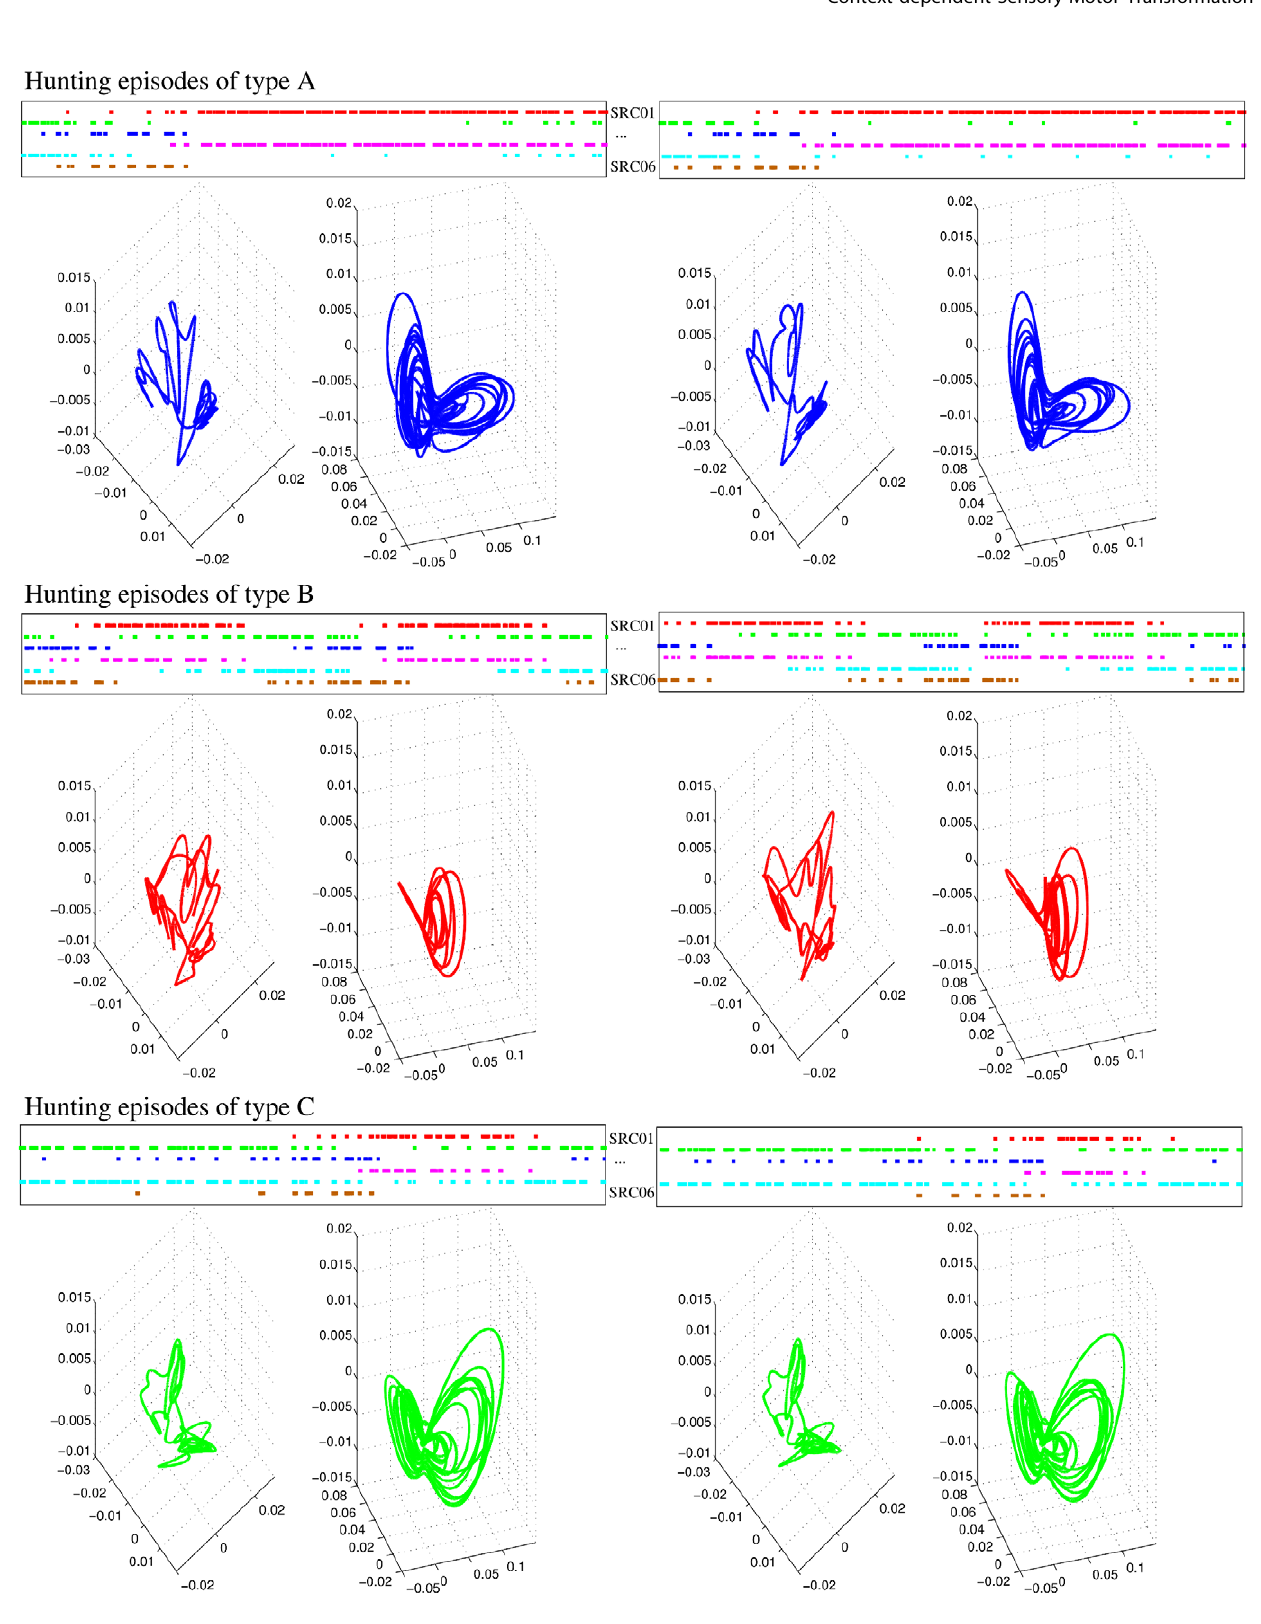
Figure 7. Principal component analysis of the sensory-motor transformation. We have selected three different types (A–C) of hunting episodes according to the duration of specific patterns of sequential activations among the SRCs. A total of six hunting episodes are shown in this figure, two examples for each kind. The top panels display the time intervals in which each neuron exceeds a threshold of 0 mV . Different colors are used to indicate each neuron. The episodes labeled as type A correspond to long activations of neurons 1 and 4 (red and magenta, respectively). The episodes labeled as type B correspond to sequential activations of similar length in all neurons, while type C episodes correspond to long